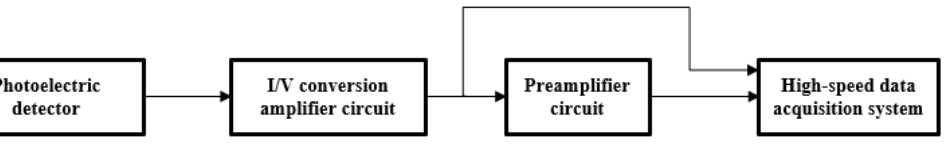
Figure 7. The design of the circuit part.